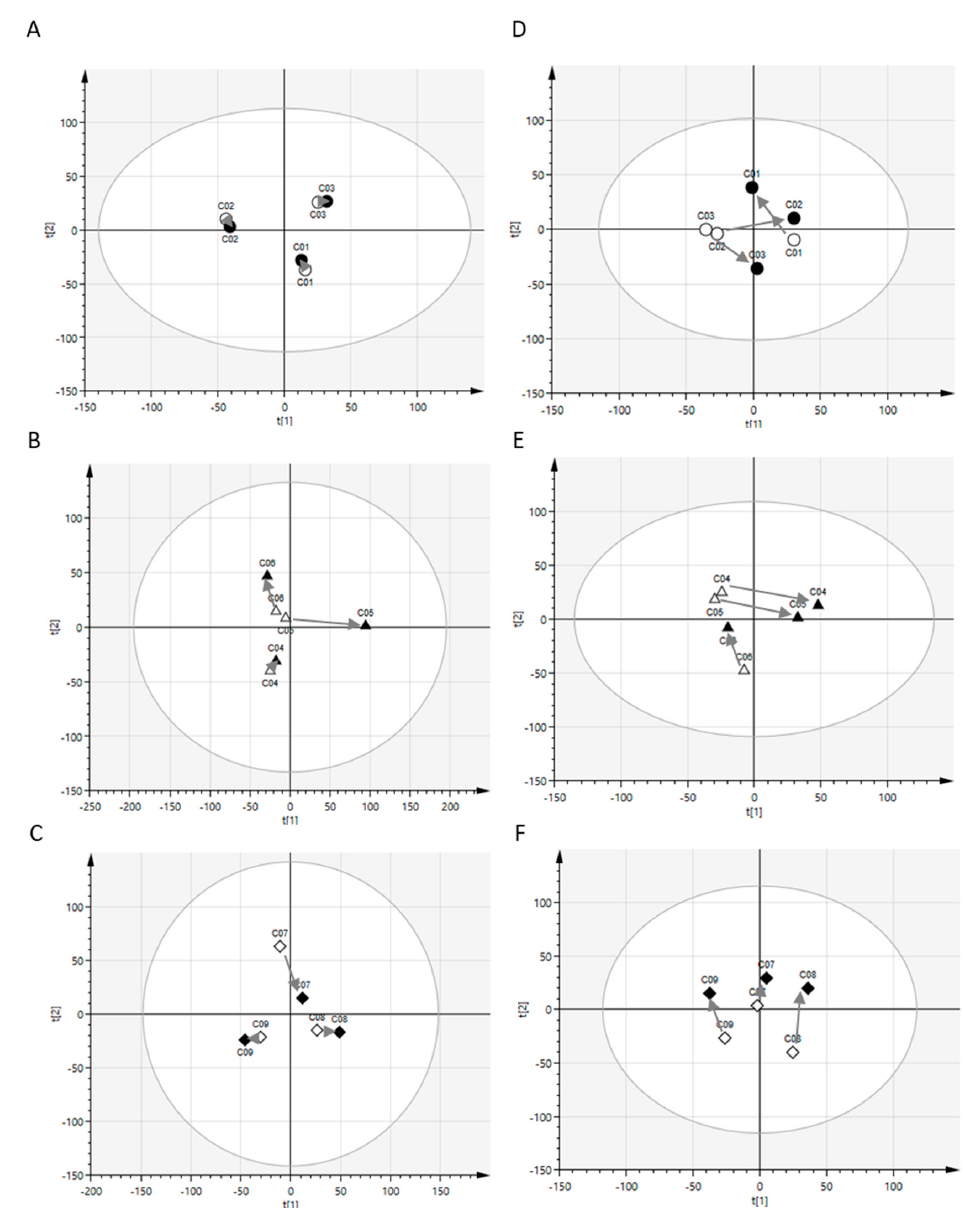
Figure 1. Principal component analysis (PCA) model of hydrophilic metabolites. Data obtained for cerebrospinal fluid (CSF) ( A – C ) and plasma ( D – F ) from preprandial (white) and postprandial (black) subjects were analyzed. The postprandial periods were 1.5 h (circle), 3 h (triangle), and 6 h (diamond). The grey arrows indicate the change in levels of different metabolites in preprandial and postprandial samples of individual subjects. The circle around the samples indicates the tolerance ellipse determined by Hotelling’s T 2 with a two-dimensional score plot (95% tolerance was set for all the data analyses in this study). Data points outside the ellipse represent the outliers (none in this study).